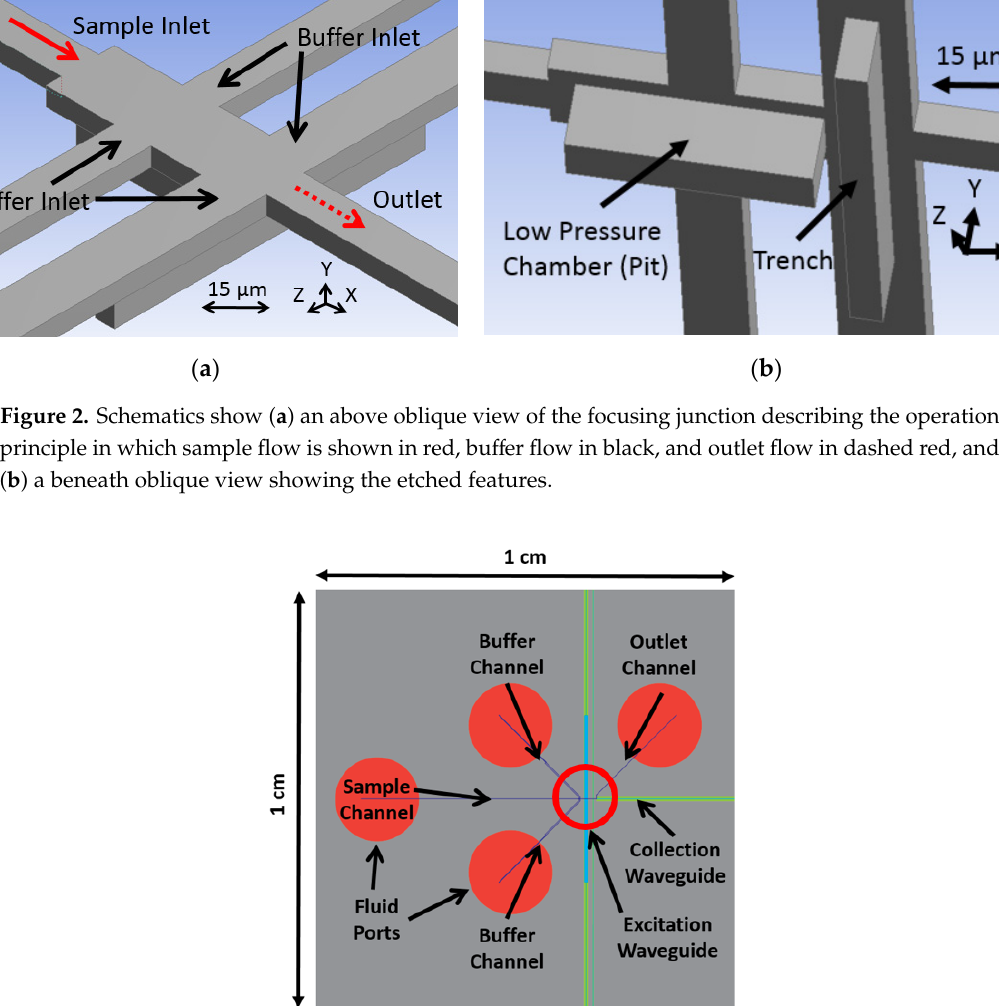
Figure 3. The focusing junction integrates into the optofluidic chip design near the center of the chip, indicated with the red ring, drawn from a top view.